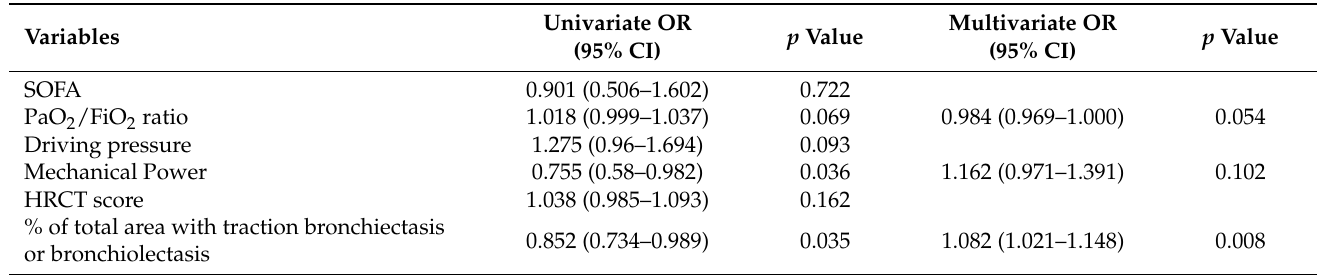
Table 3. Univariate and multivariate logistic regression for analyzing independent risk factors for 60-day mortality.